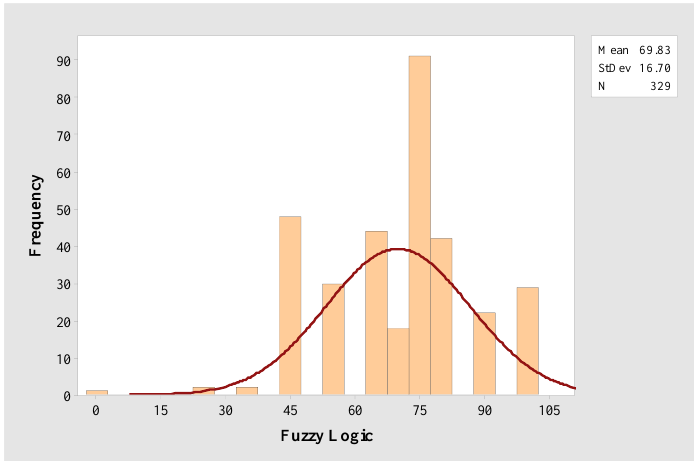
Source : Sample Survey, 2022